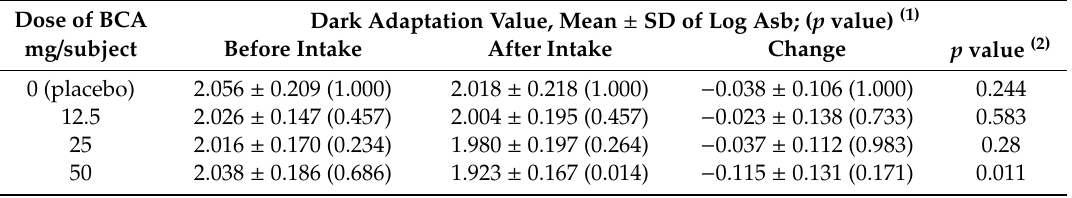
Table 5. Dark adaptation threshold changes before and after intake of the test drink. Dose of BCA